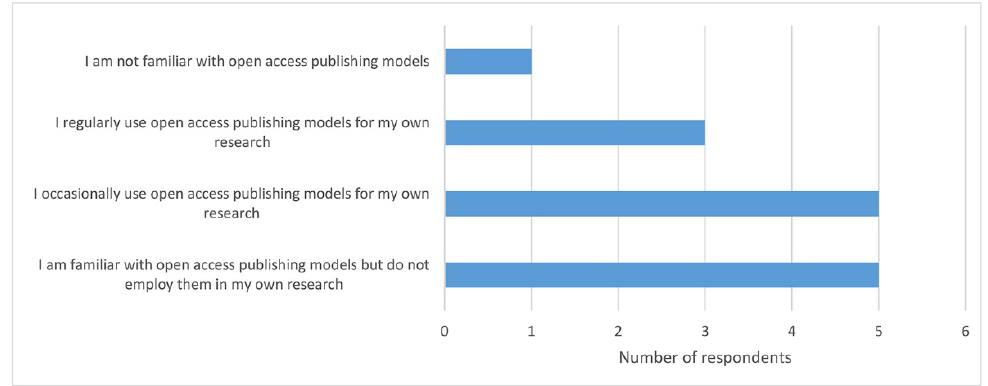
Figure 1 Open access